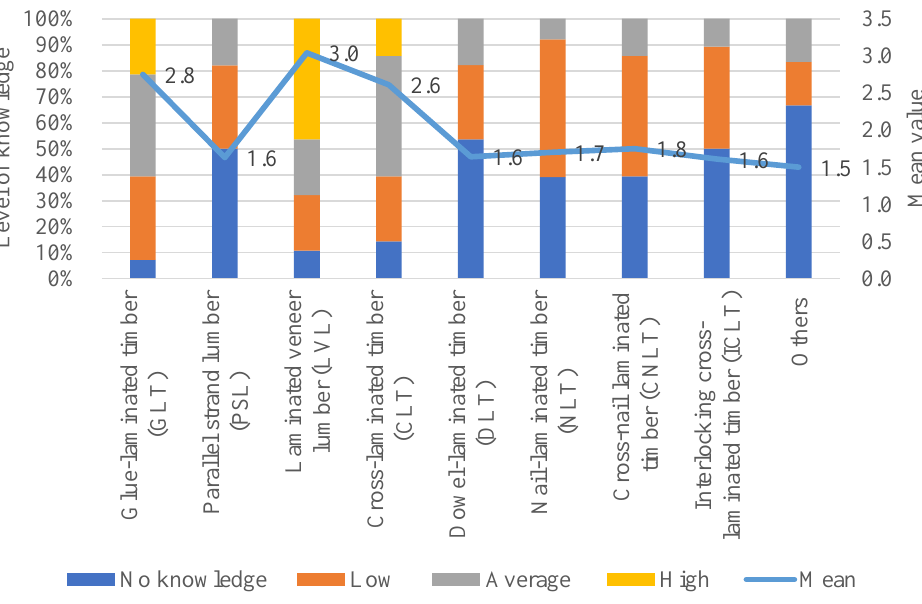
Figure 2. Level of knowledge about mass timber projects.